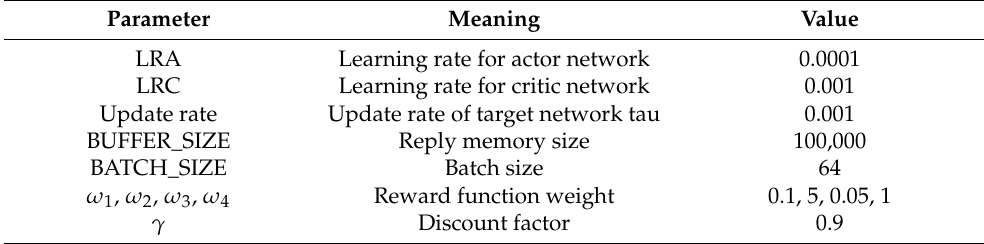
Table 1. Training parameter settings.